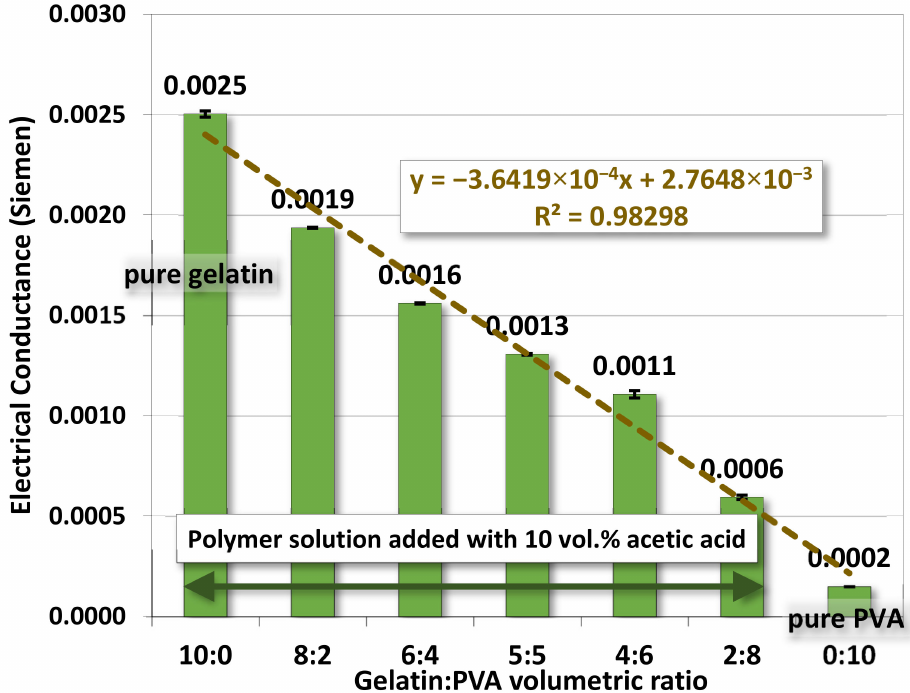
Figure 3. The average electrical conductance of gelatin/PVA mixed